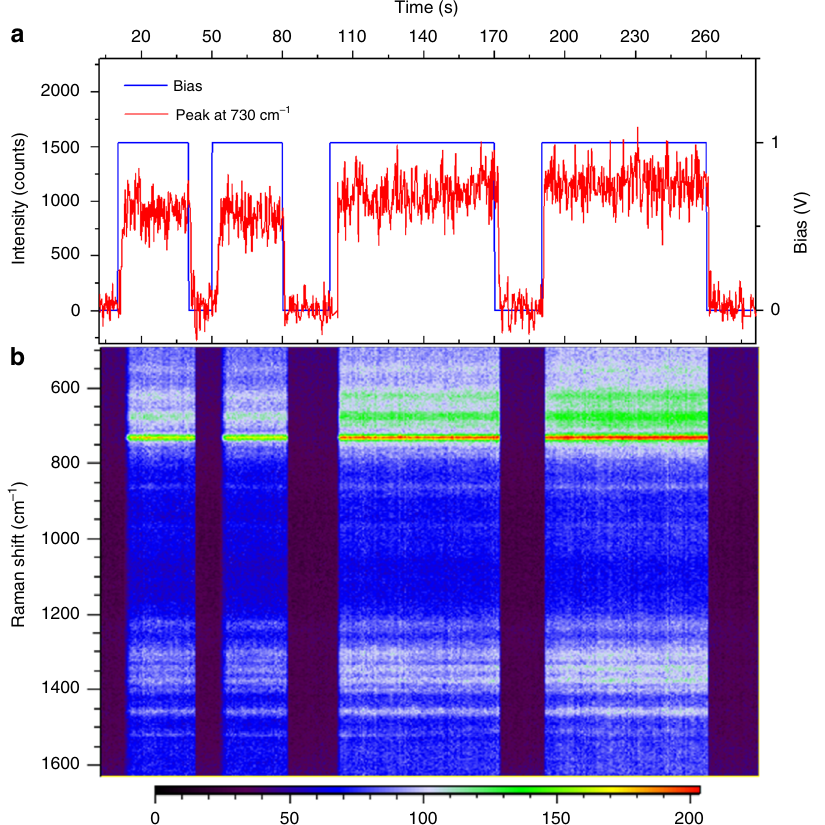
Fig. 3 Reproducible SERS spectra of a trapped adenine-multilayer-adsorbed gold nanourchin (A – AuNU) by controllable trapping through turning on and off the bias. a Time trace of intensity of the Raman peak at 730 cm – 1 (red line) of a single A – AuNU trapped in a nanopore by incident laser of 6-mW power and applied bias of 1 V (blue line). b Corresponding time series of the stable SERS spectra produced by the trapped A – AuNU. The color bar represents the